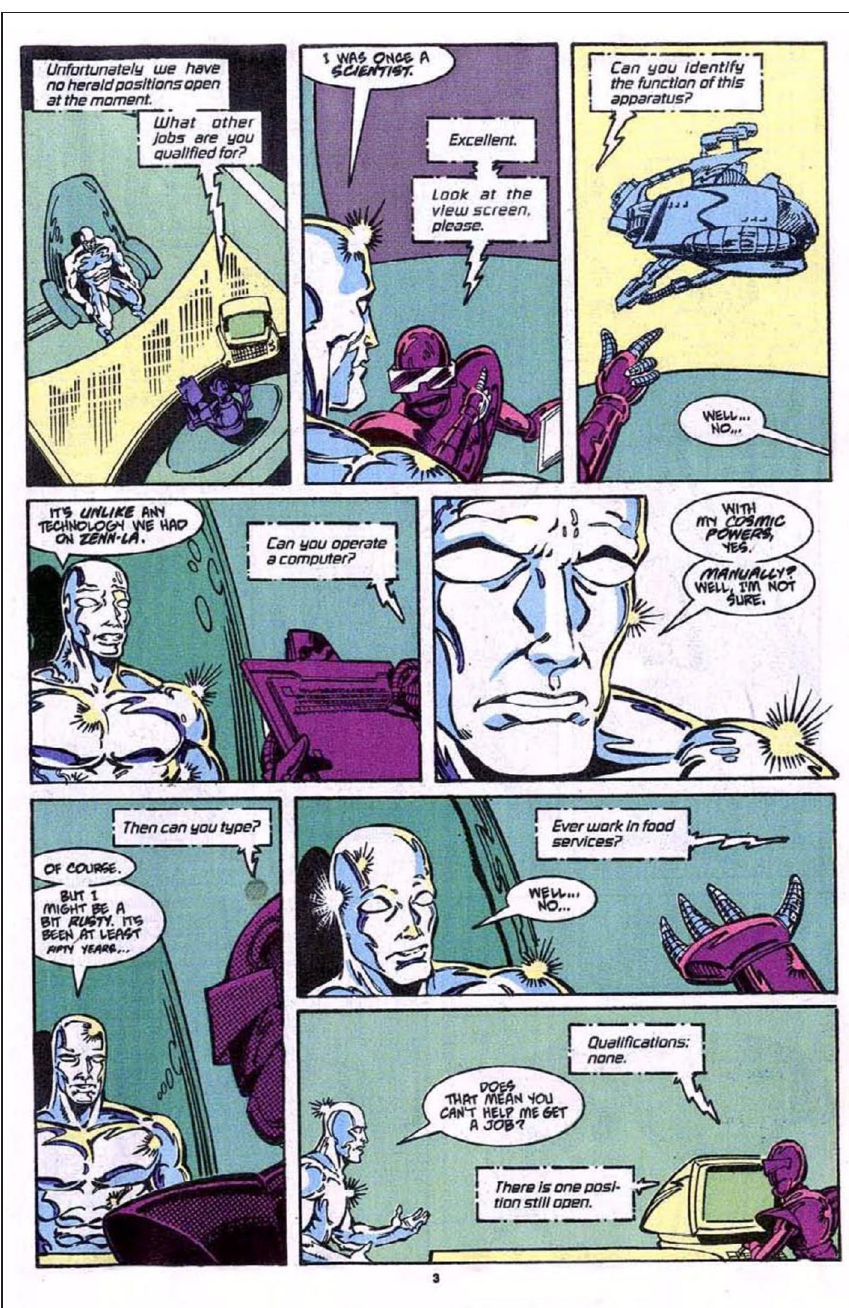
Figure 2: The Silver Surfer #41. New York: Marvel, 1990, p. 3. Jim Starlin (writer), Ron Lim (penciler), Tom Christopher (inker), Ken Bruzenak (letterer), Tom Vincent (colorist), Craig Anderson (editor), Tom Defalco (Chief). © 1990 Marvel Entertain- ment Group,